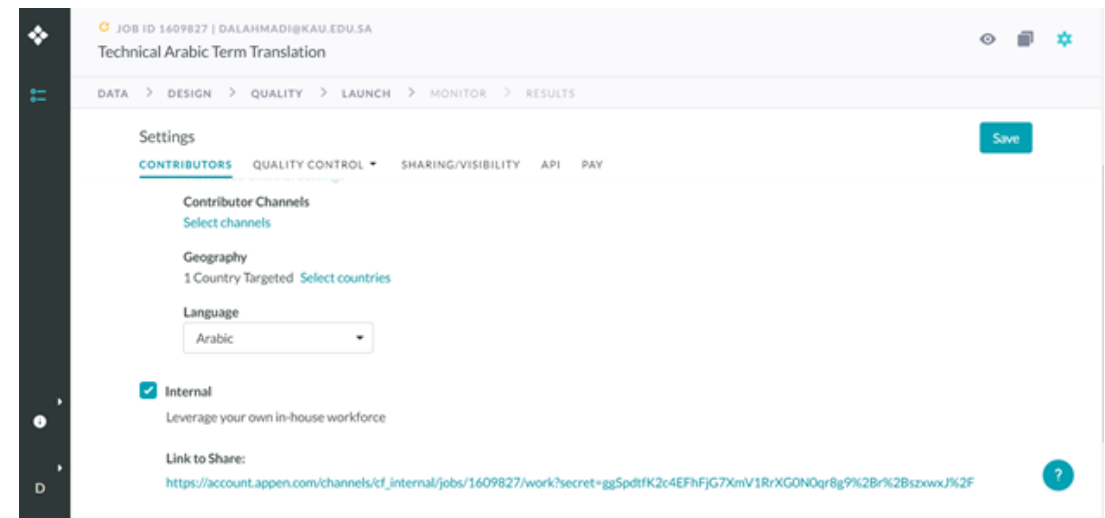
Figure 14. Limited contributors’ features for Arabic language in Appen.